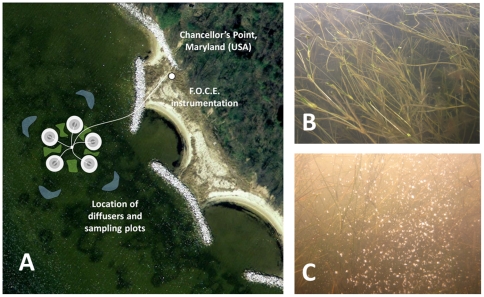
Location of mid-salinity Free Ocean Carbon Enrichment (FOCE) experiments within the St. Mary's River, Maryland (USA) in May-July 2010.(A) Individual CO2 diffusers (white) generated halos of high CO2/low pH conditions (5 cm and 40 cm distances in grey; 100 cm locations in green; 500 cm ambient sites in blue.) (B) Dense meadow of Ruppia maritima from the near shore site. (C) Bubbles emitted from one of the CO2 diffusers (compare to CO2 natural vent site, Fig 1.B).